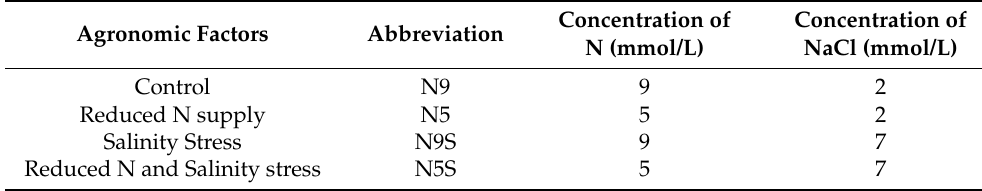
Table 1. Concentration of nutrients (N and NaCl) and